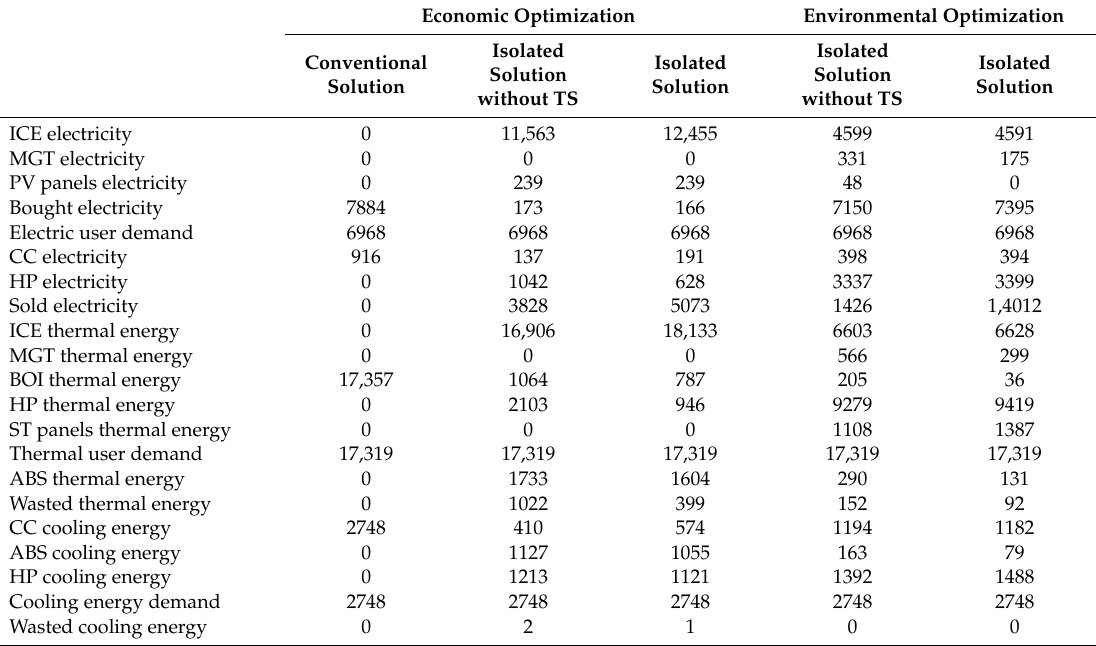
Table 8. Total optimal annual energy magnitudes (MWh)—isolated solutions.